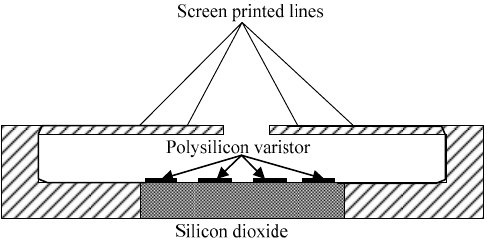
Figure 1. Schematic diagram of silicon piezoresistive pressure sensor.